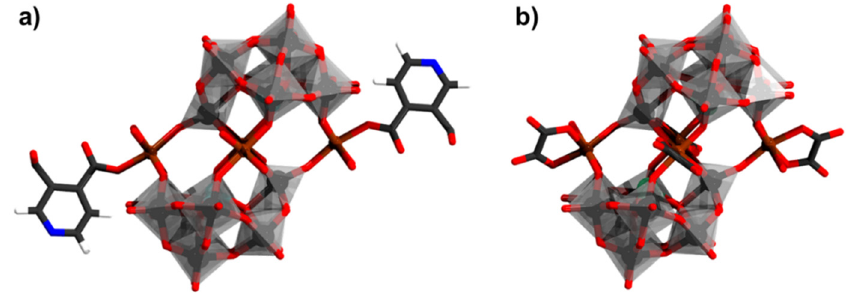
Figure 16. ( a ) [Fe 4 (H 2 O) 8 (pdc) 2 ( β -SbW 9 O 33 ) 2 ] 6 − ; ( b ) [Fe II4 (ox) 4 (H 2 O) 2 ( β -SbW 9 O 33 ) 2 ] 14 − Color code: X = green (but covered), Fe = brown, {WO 6 } = gray octahedra, W = black, and O = red. H atoms on aqua ligands are omitted.